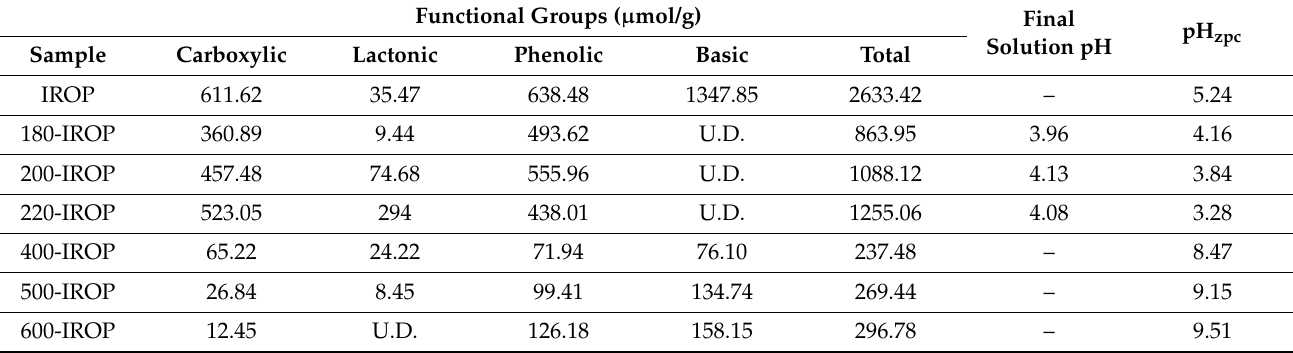
Table 3. Acidic and basic functional groups concentrations ( µ mol/g), final solution pH and surface pH at zero-point charge (pH zpc ) of the impregnated raw olive pomace and the produced hydrochars and biochars from the HTC and slow pyrolysis at 180, 200, and 220 and at 400, 500, and 600 ◦ C, respectively (–: unmeasurable property; U.D.: undetected measurement). Functional Groups ( µ